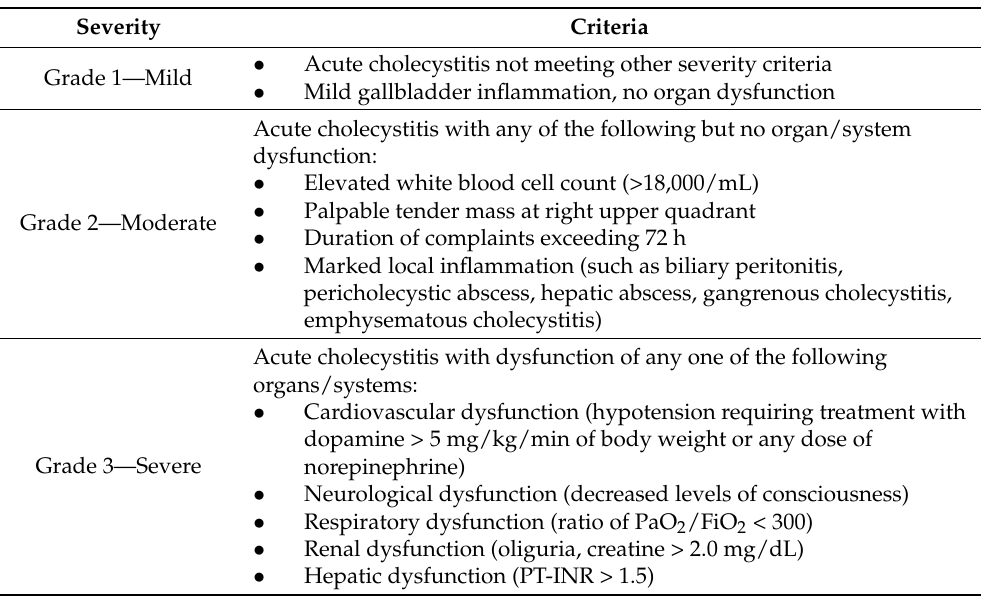
Table 3. Tokyo guidelines for grading the severity of acute cholecystitis,